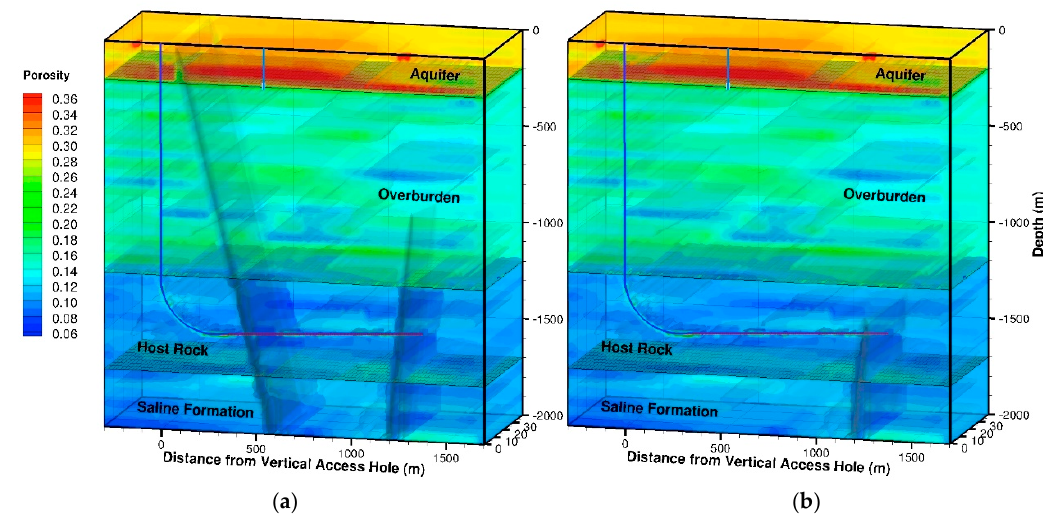
Figure 4. Porosity distribution within modeled symmetry cell, showing hydrostratigraphy and location and extent of ( a ) two faults and ( b ) one fault intersecting the sub ‐ horizontal disposal section of the borehole repository. Note that the actual model domain extends in the X ‐ direction from − 2200 to 3550 m. Applying symmetric boundary conditions at the X ‐ Z planes is equivalent to the assumption of an infinite number of wells spaced 100 m apart in the Y ‐ direction.